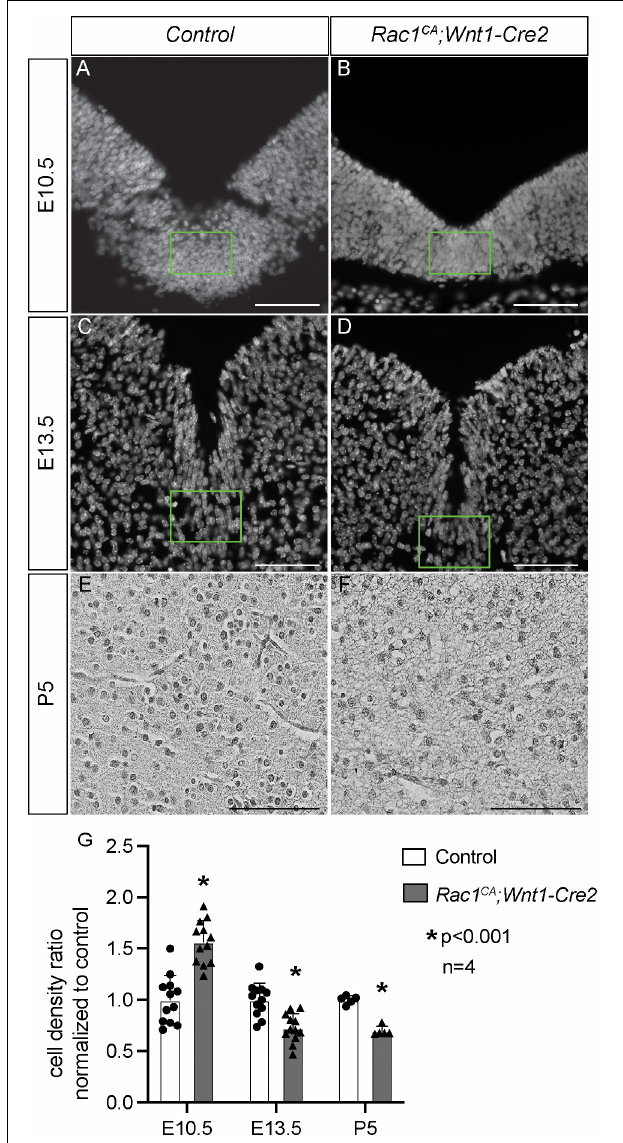
FIGURE 4 | Rac1 CA ;Wnt1-Cre2 mice exhibit altered cell density in ventral midbrain. (A–C) Grayscale conversion of DAPI staining on coronal sections of littermate control midbrain (A,C) and that of Rac1 CA ;Wnt1-Cre2 (B,D) at E10.5 (A,B) and E13.5 (C,D) . Ventral midbrain tissue defined in green rectangles are used for quantification and statistical analysis. (E,F) Grayscale conversion of H.E. staining on coronal sections of littermate control midbrain (E) and that of Rac1 CA ;Wnt1-Cre2 (F) at P5. (G) Quantification and statistical analysis of cell density in A–F . Scale bar in A–D , 50 µ m. Scale bar in E,F , 200 µ